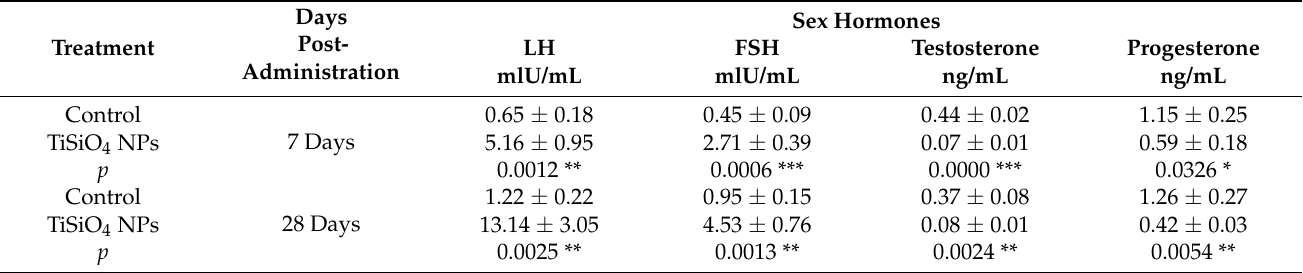
Table 4. Sex hormones (FSH, LH, testosterone, and progesterone) levels in serum male rats exposed orally to 250 mg ≤ 50 nm TiSiO 4 NPs/kg b.w.